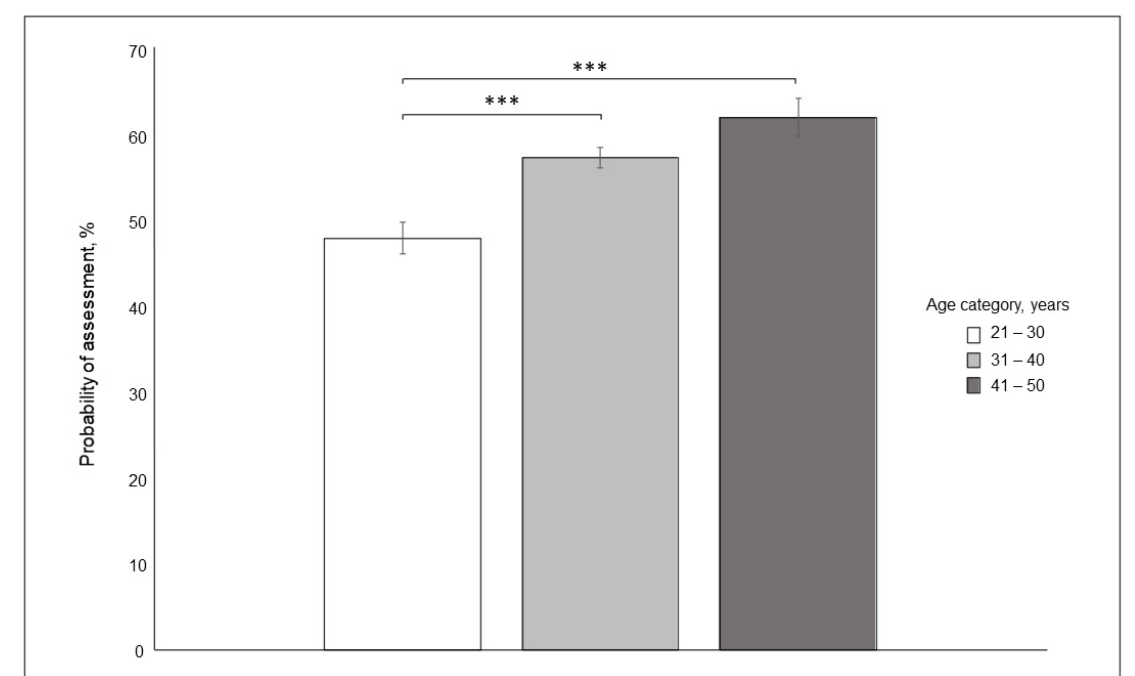
Figure 3. Differences between probability of risky situation assessment between age category of the respondents. LS means ± S.E., *** p < 0.0001.